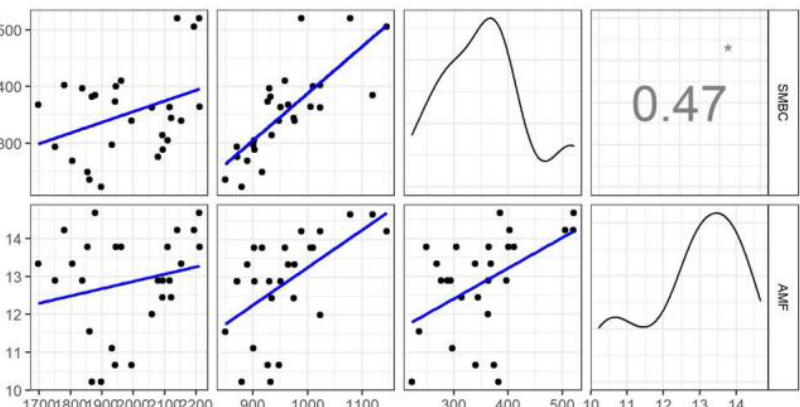
Figure 7. Correlation matrix chart of chemical and biological variables under different tillage practices and crop rotation. Soil organic carbon stock (SOCS), soil microbial respiration (CO 2 ), soil microbial biomass carbon (SMBC), and arbuscular mycorrhizal fungal (AMF) root colonization. The upper panels show Pearson’s correlation coefficients while the lower panels report the scatter plots. *, **, *** indicates significance at p < 0.05, < 0.01, and 0.001, respectively.